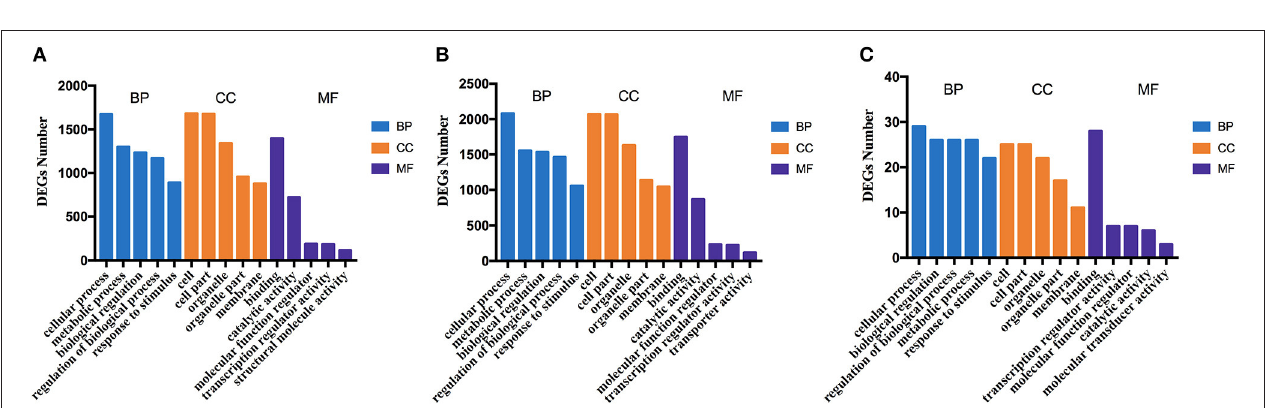
FIGURE 7 | The expression level of DEGs displayed with heat map. The x -axis represents samples. The y -axis represents DEGs. The color depth represents –log10 (FPKM). The red means high expression level; the blue means low expression level. (A) DEGs of group TNNI2. (B) DEGs of group ACTA1. (C) DEGs of group TNNI2-ACTA1 V1.